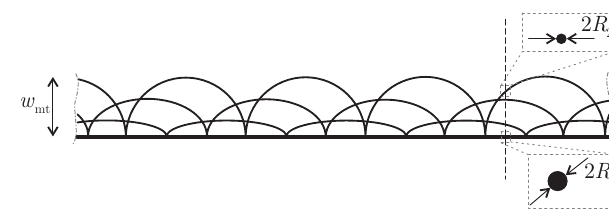
Fig. 3. Four-wire Heytether